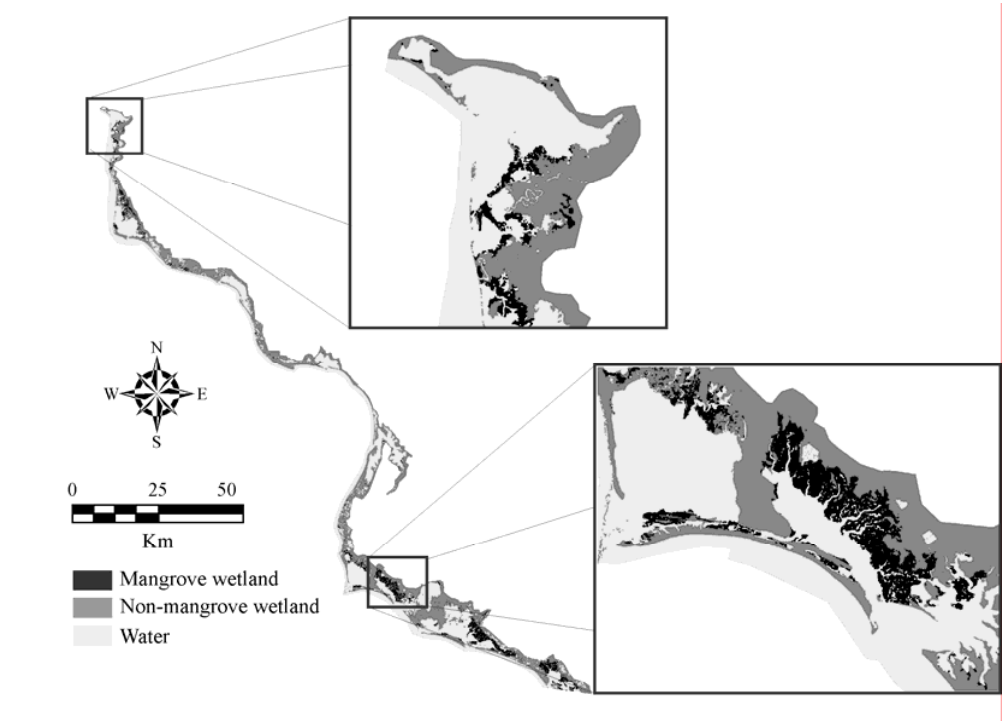
Figure 8. Maps of mangrove and non-mangrove areas obtained from the spectral distance map and the classification